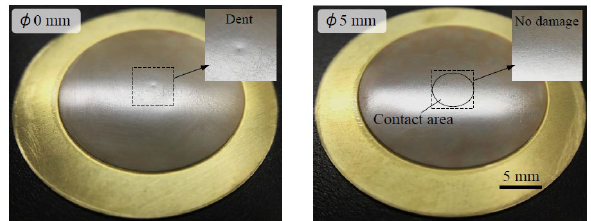
Fig. 6 Photographs of surface of PZT ceramic after cyclic loading with ϕ 0 and ϕ 5 mm fixtures, showing localized failure caused by mechanical contact with loading fixture.